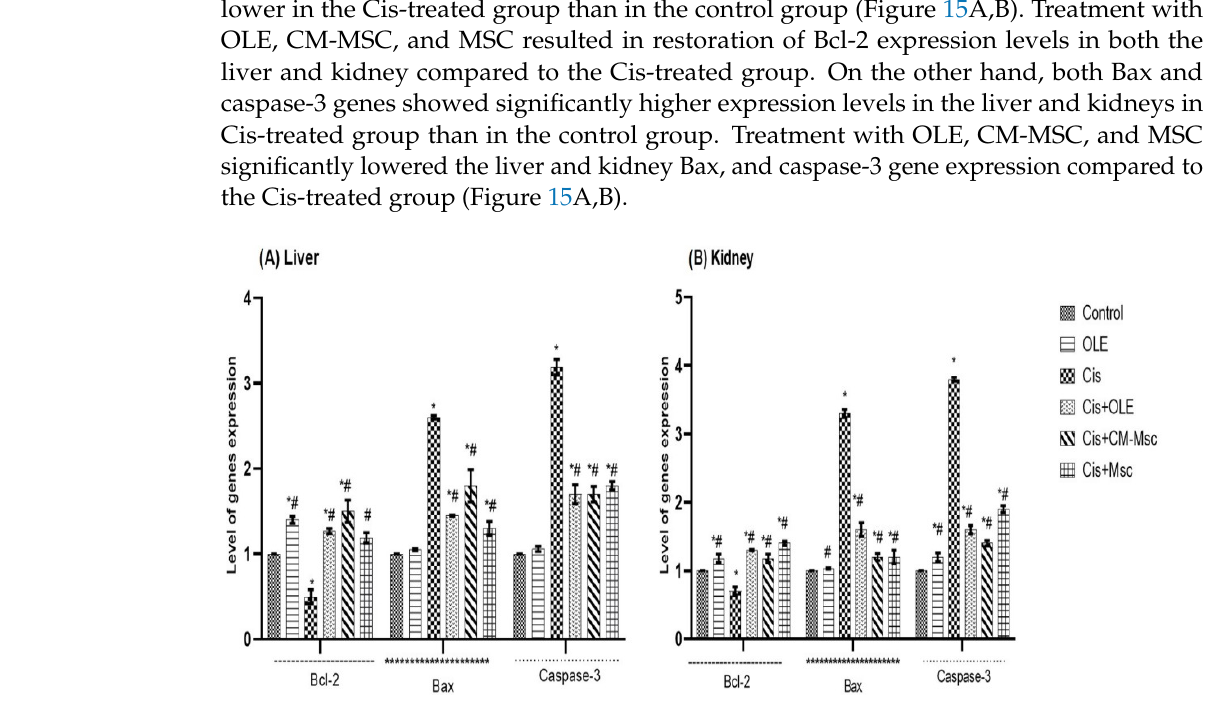
Figure 15. Bcl-2, Bax, and caspase-3 genes expression level ( A ): liver tissues, ( B ): kidney tissues. Values are expressed as mean ± SD. One way ANOVA was used to analyze the data. Statistically significant compared to control group (*) and cisplatin group (#); p < 0.05.